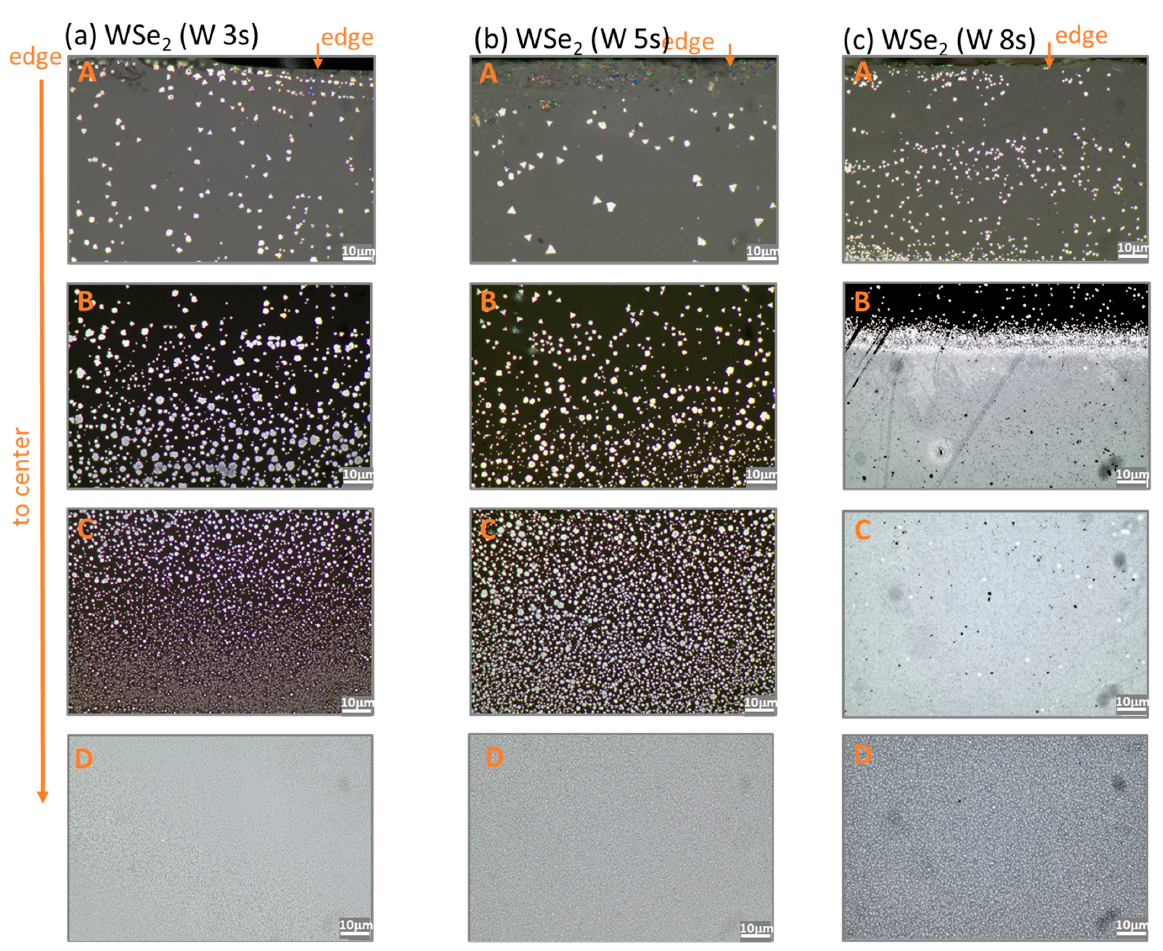
Figure 2. Optical microscope images of WSe 2 flakes grown by TAC method (pre ‐ deposited W layer of ( a ) 3 s; ( b ) 5 s and ( c ) 8 s; scale bars 10 μ m). Flakes with triangular, dendrite and hexagonal ‐ like shapes are concentrated near the substrate edges (A and B sections). Moving to the center, flakes attempt to overlap (C section) and finally turn to continuous layer with dense morphology; however, for the samples with pre ‐ deposited W layer for 3 and 5 s, still some voids may exist in the places where precursor W was not deposited. (D section).